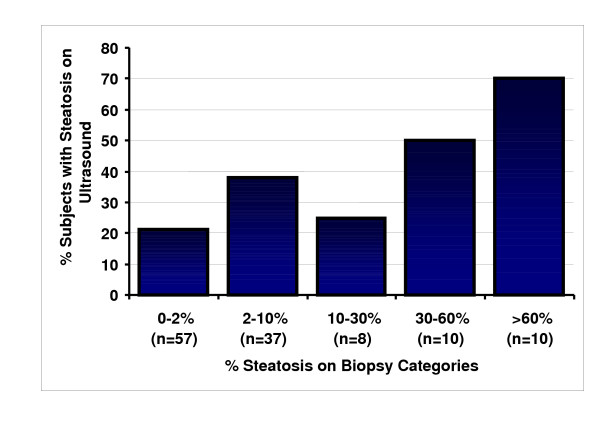
Comparison of steatosis on biopsy versus ultrasound. For each of the five categories of amount of steatosis on biopsy, the percentage of patients in those categories with a positive ultrasound for steatosis is displayed. rs = 0.27, p = 0.003.